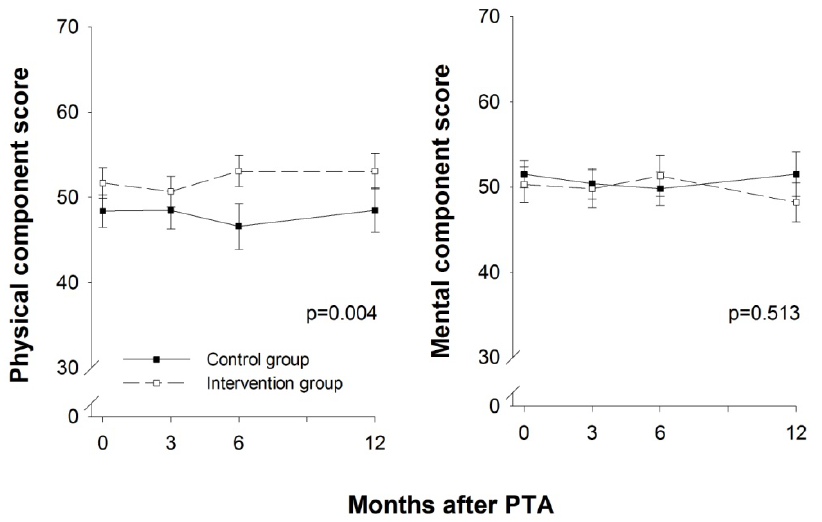
Figure 5. SF-36 component scores. A score of 0 represents the worst possible health, and 100 represents the best possible health. SF-36 = Short Form-36 Health Survey. Values are mean, error bars indicate